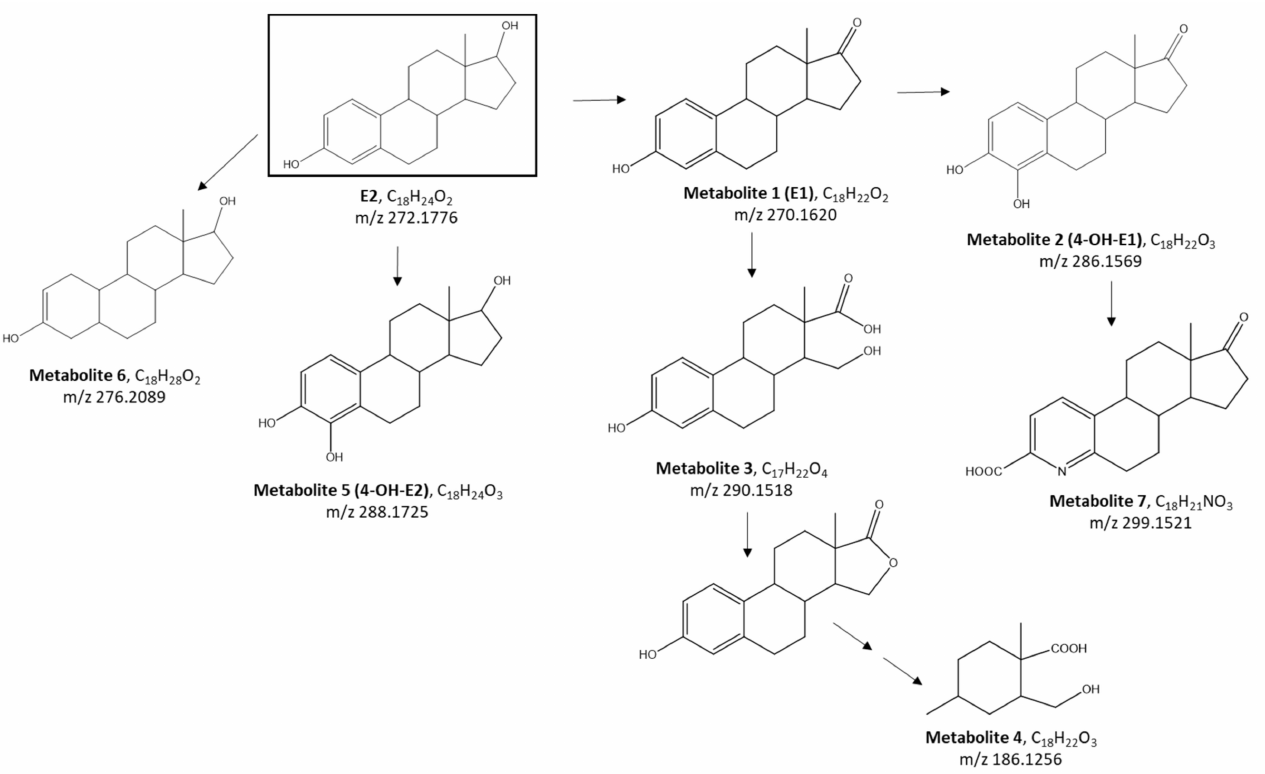
Figure 4. Proposed biodegradation pathway of E2, obtained based on the metabolites identified by the suspect and non-target